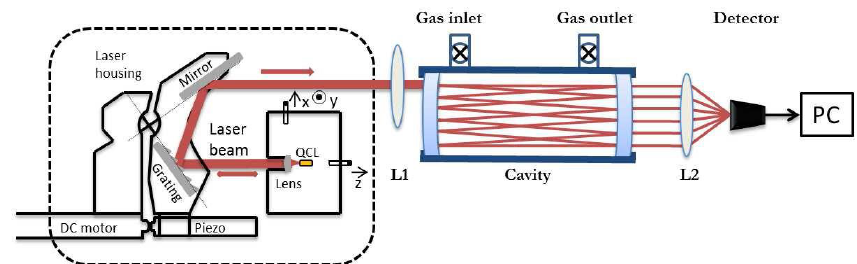
Figure 1. A schematic view of the external cavity quantum cascade laser (EC-QCL) showing the arrangement of the laser components including grating, mirror, and step motors. The laser was mounted vertically on a copper block due to polarization, in front of which a lens in a 3D-positioning system was installed. The light exited at the front and was guided via two focusing lenses (L1, L2) and a high finesse off-axis cavity onto the thermo-electrically cooled detector.